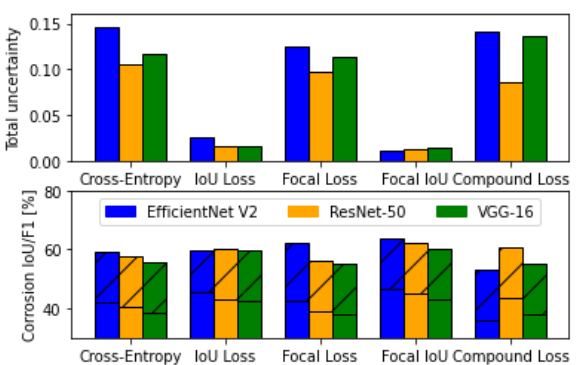
Figure 2. Total uncertainties and corrosion class related metrics of Deeplab V3+ models with respect to validation set consisting of different backbones and trained on various loss functions. The hatched bar sections indicate the difference between IoU and F1